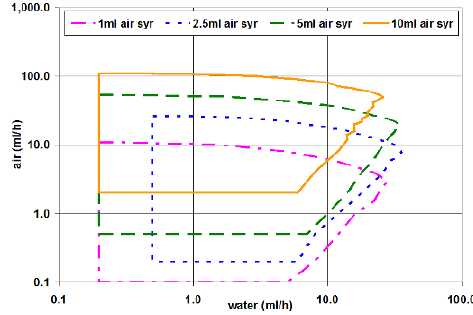
Figure 7. Limits of experimental flow